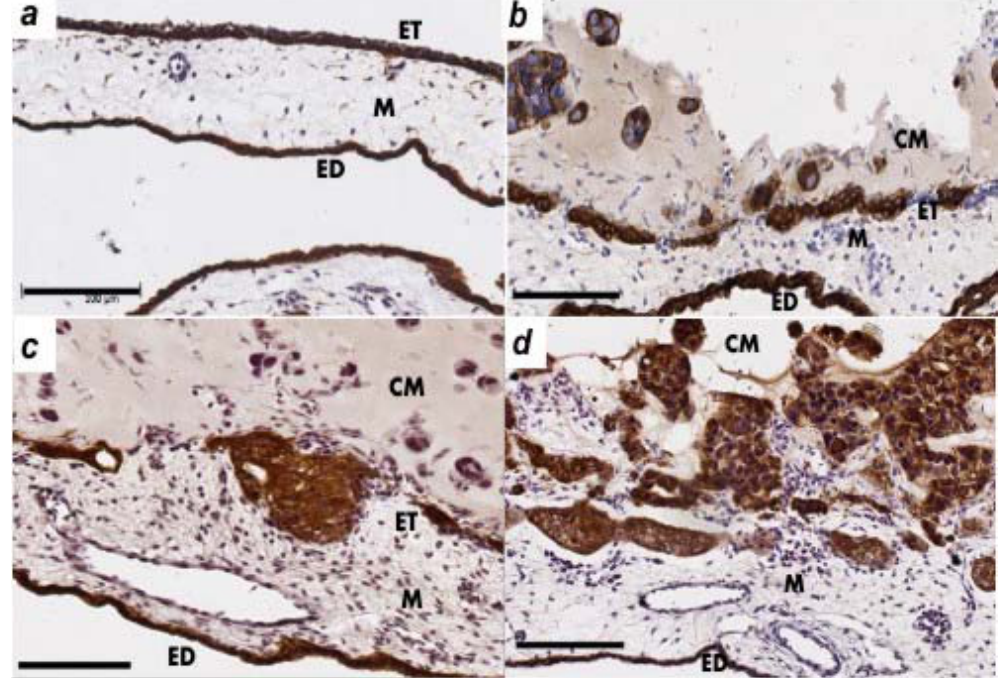
Figure 3. Invasion of ovarian cancer cells in the chick chorioallantoic membrane (CAM). ( a ) Control showing the normal structure of the CAM layers; ectoderm (ET), mesoderm (M) and endoderm (ED); ( b ) OVCAR-3; ( c ) SKOV-3; and ( d ) OV-90 cancer cell matrigel grafts (CM) were placed on top of the ectoderm layer and cancer cell invasion into the CAM mesoderm was assessed in day 14 chick embryos. CAM paraffin sections (6 µm) were immunostained with cytokeratin antibody. Original magnification ×200, scale bar 100